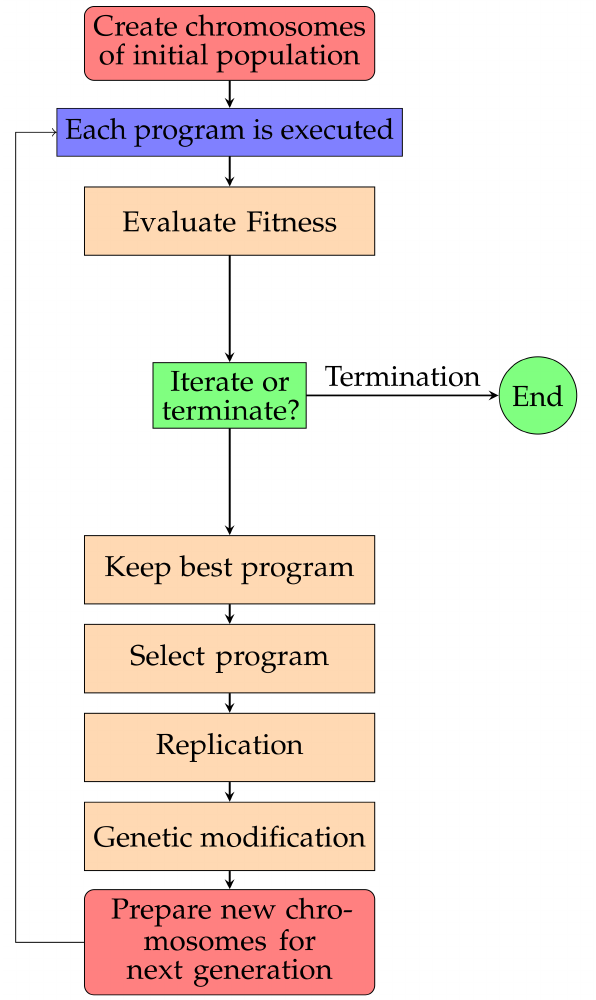
Figure 8. The model working steps of the GEP